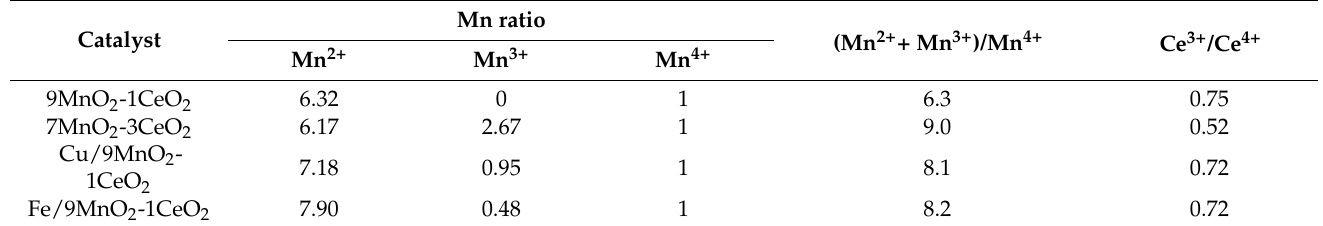
Table 3. The Mn 2p and Ce 3d XPS spectra of selected catalysts.